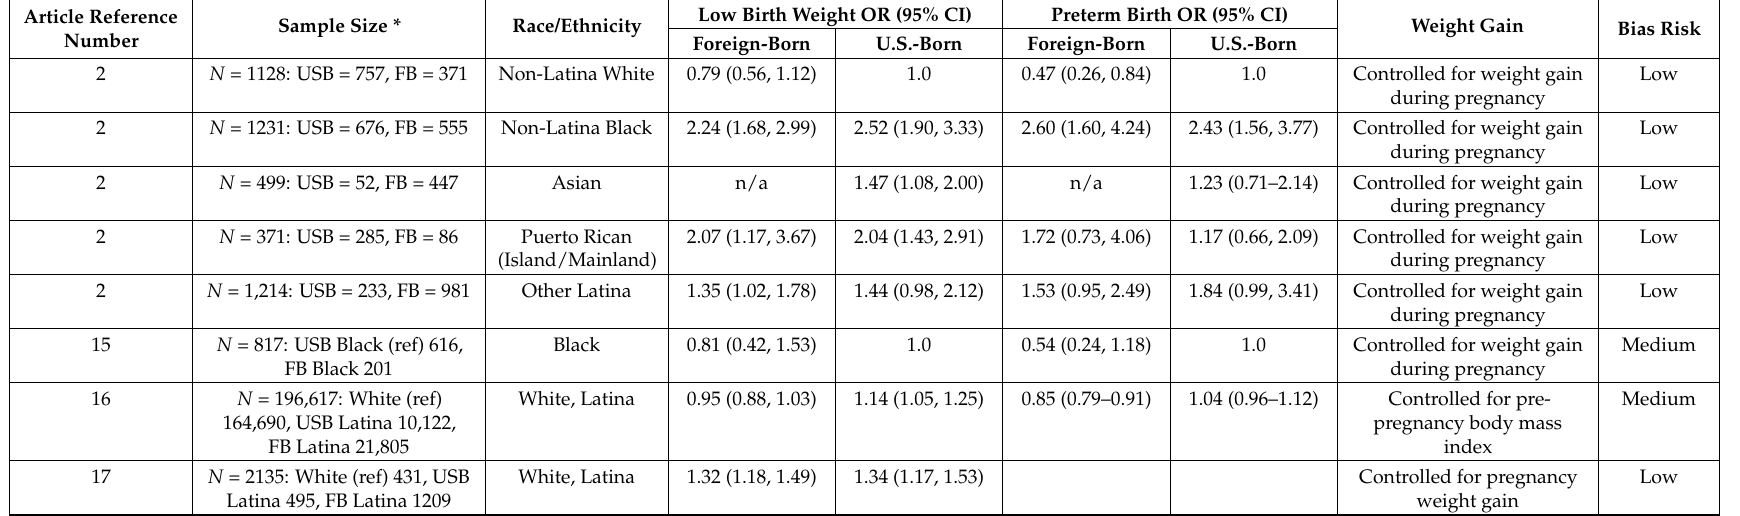
Table 1. Characteristics and results from studies on birth outcomes by nativity measuring weight gain during